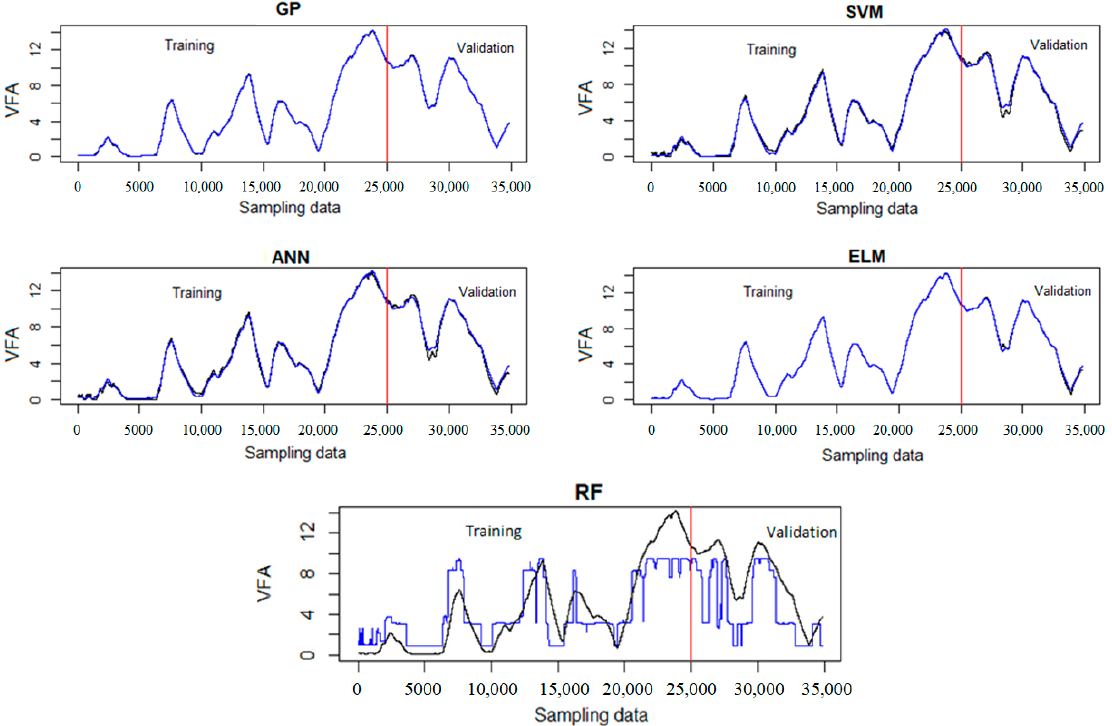
Figure 6. Prediction results of di ff erent soft sensors; black is the actual values and blue is the predicted volatile fatty acid (VFA) values. GP: genetic programming; SVM: support vector machine; ANN: artificial neural network; ELM: extreme learning machine; RF: random forest.